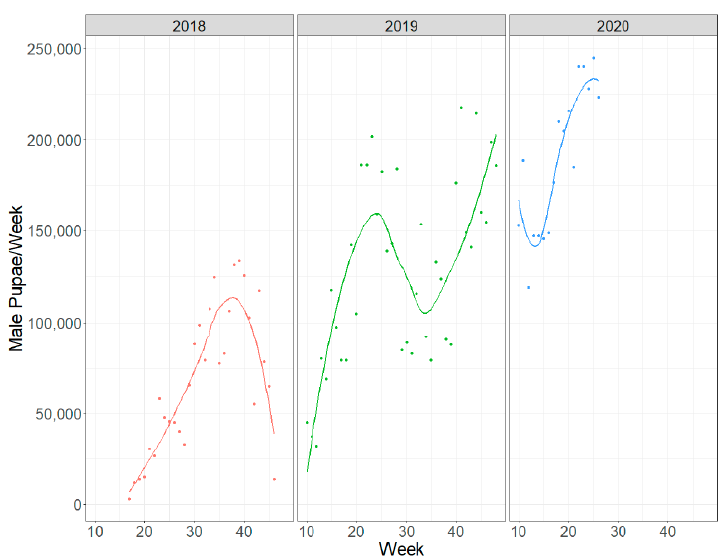
Figure 8. Male pupae production over the